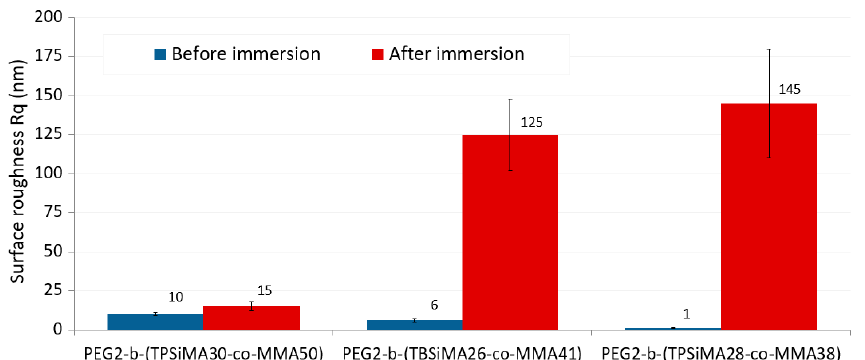
Figure 7. Surface roughness values calculated from the topographic images (10 μ m × 10 μ m) of PEG2- b -(TPSiMA30- co -MMA50), PEG2- b -(TBSiMA26- co -MMA41), and PEG2- b -(TPSiMA28- co -MMA38).